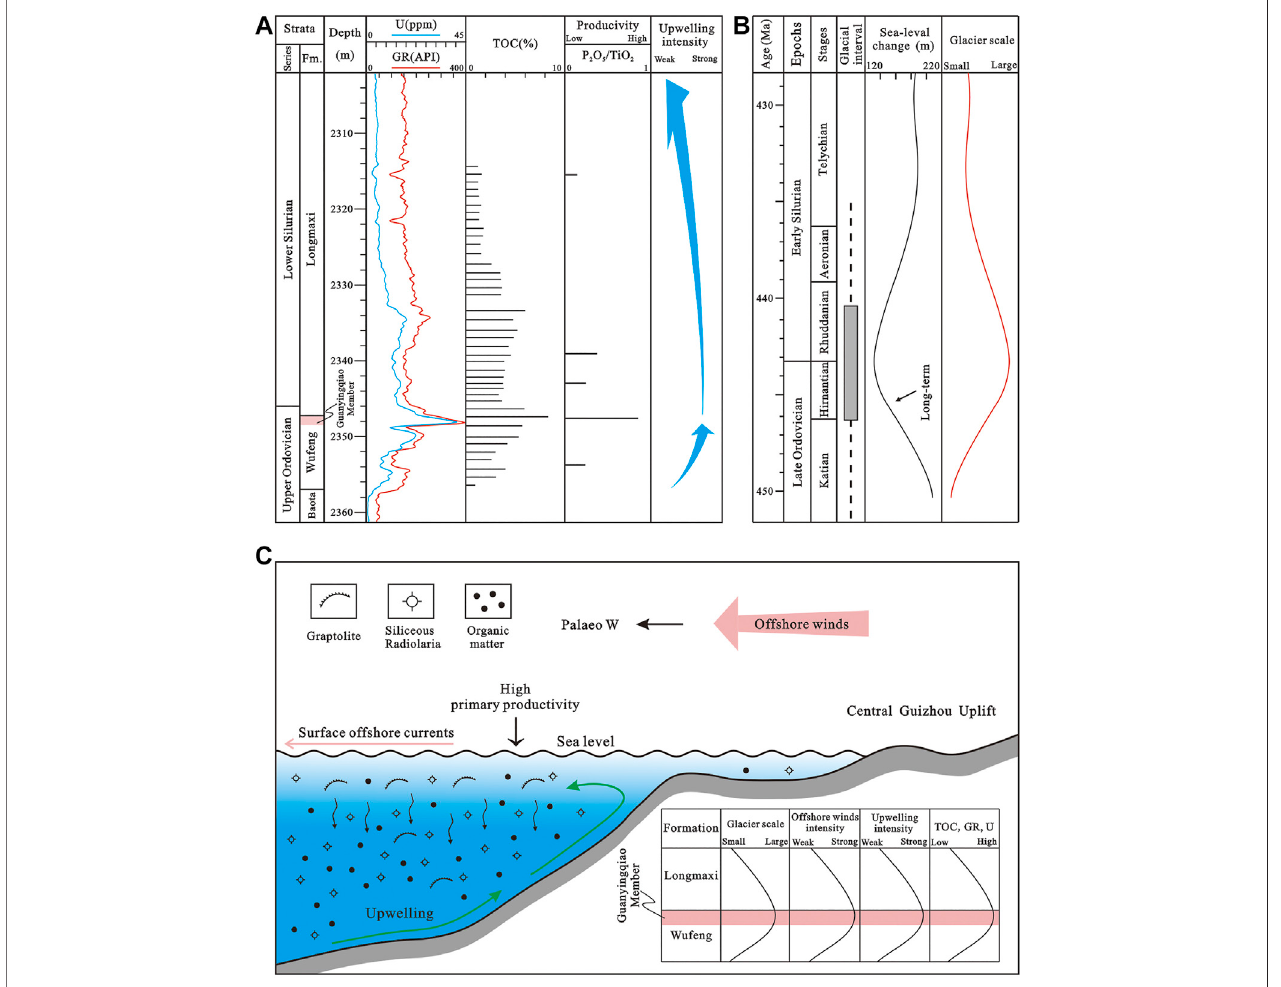
FIGURE8 |(A) Vertical variations inthe GR value, TOC content, and productivity metric(i.e., the P 2 O 5 /TiO 2 ratio) of theWufeng – Longmaxi Formation black shales in well N211 and the upwelling intensity [data for the P 2 O 5 /TiO 2 ratio were obtained from Wang et al. (2017), and the upwelling intensity is from Zhao et al. (2019)]. (B) Glacier developmentand global sea-levelchangeduring the LateOrdovician – early Silurian, according toHaq and Schutter(2008). (C) Paleoenvironmental mode during the deposition of the Wufeng – Longmaxi Formation black shales in the Upper Yangtze Region.